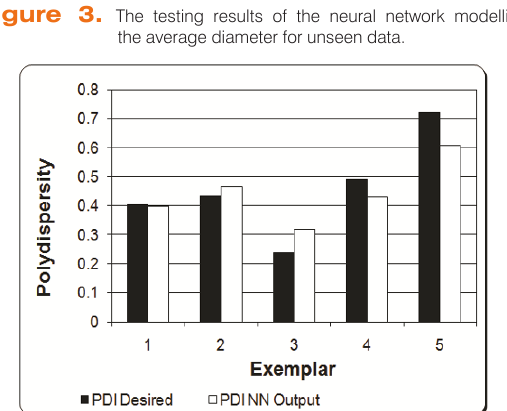
The testing results of the neural network modelling of the polydispersity for unseen data